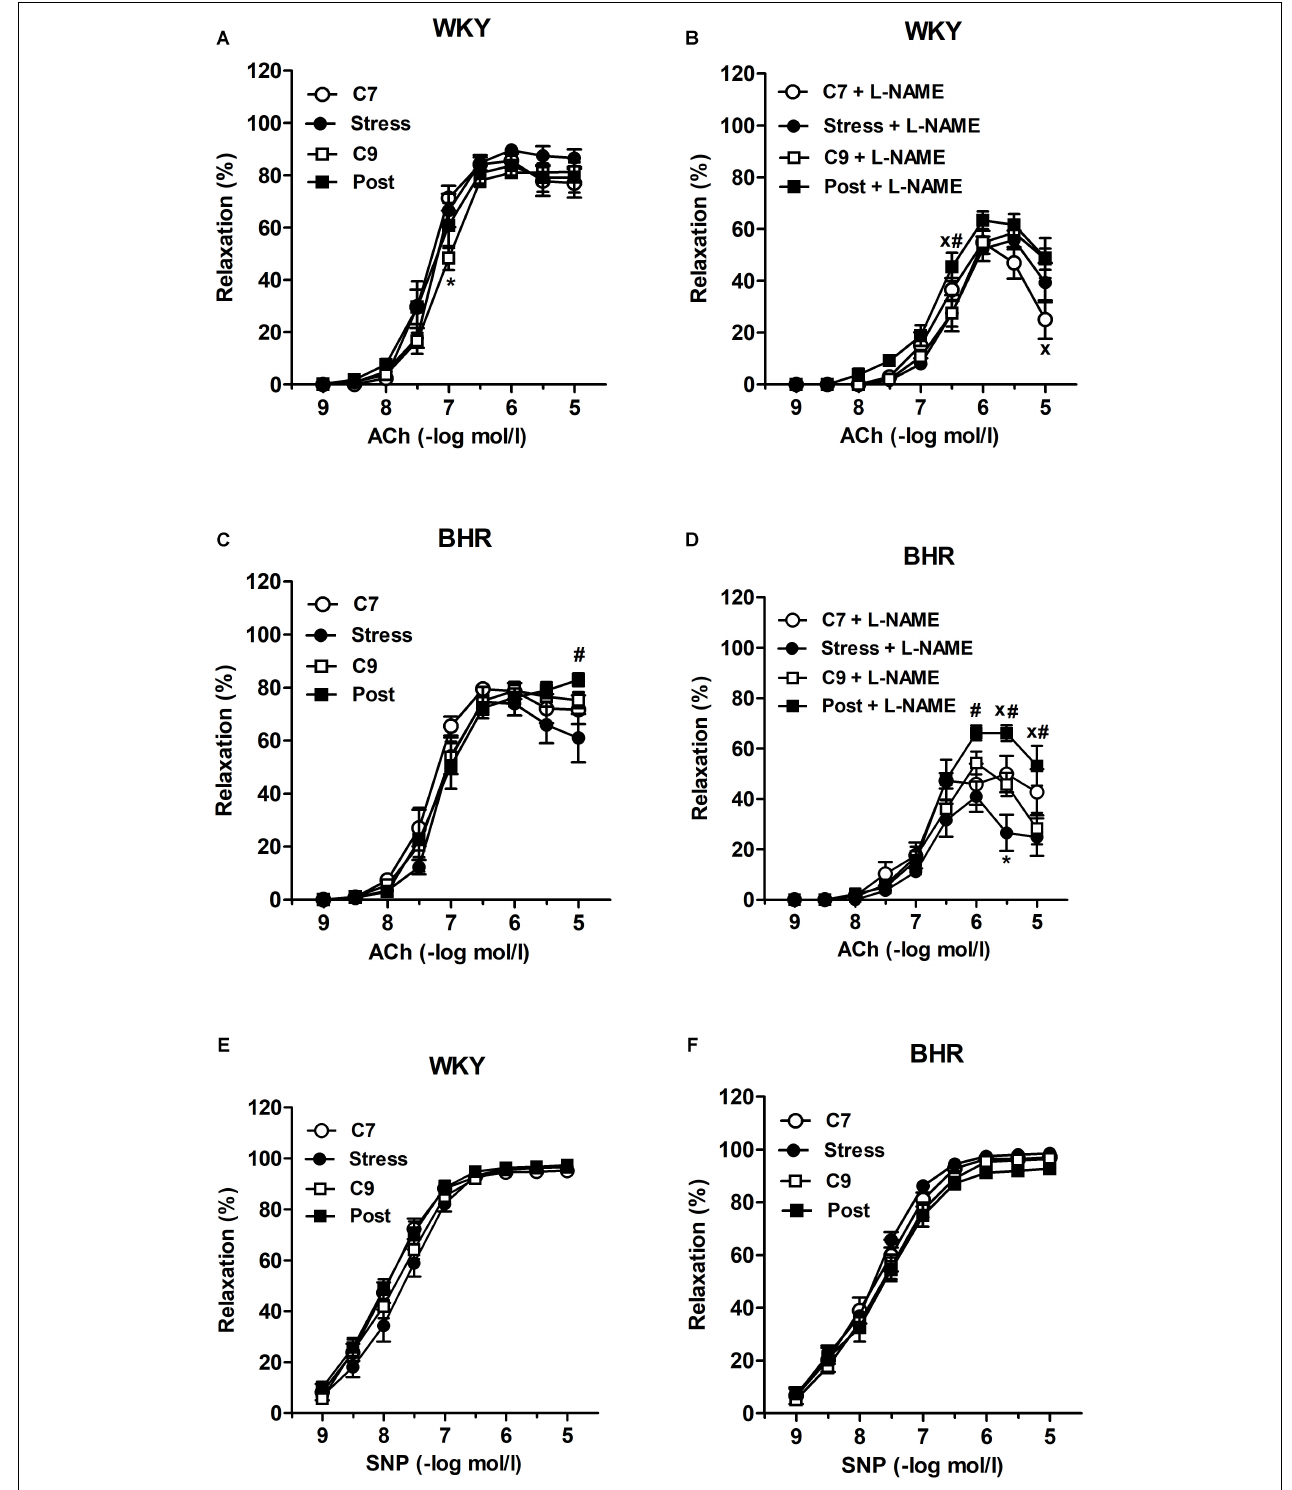
FIGURE 4 | Vascular responses to acetylcholine (A–D) and sodium nitroprusside (E,F) in the isolated femoral arteries of normotensive Wistar-Kyoto (WKY) and borderline hypertensive (BHR) rats before (A,C) and after (B,D) incubation with nitric oxide synthase inhibitor N G -nitro- L -arginine methyl ester (L-NAME, 300 µ mol/l). ACh, acetylcholine; C7, seven-week controls; C9, nine-week controls; Post, post-stress; SNP, sodium nitroprusside. The results are mean ± SEM, n = 6–10/group. Symbols: ∗ p < 0.05 vs. seven-week controls (C7) of the same phenotype, # p < 0.05 vs. stress of the same phenotype, x p < 0.05 vs. nine-week controls (C9) of the same